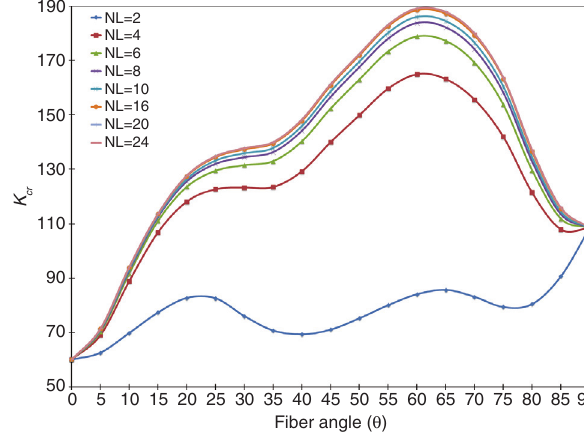
Figure 13 Critical buckling load parameter for clamped antisym- metric cylindrical skew panel (Ø = 15 ° , α = 30 ° ).